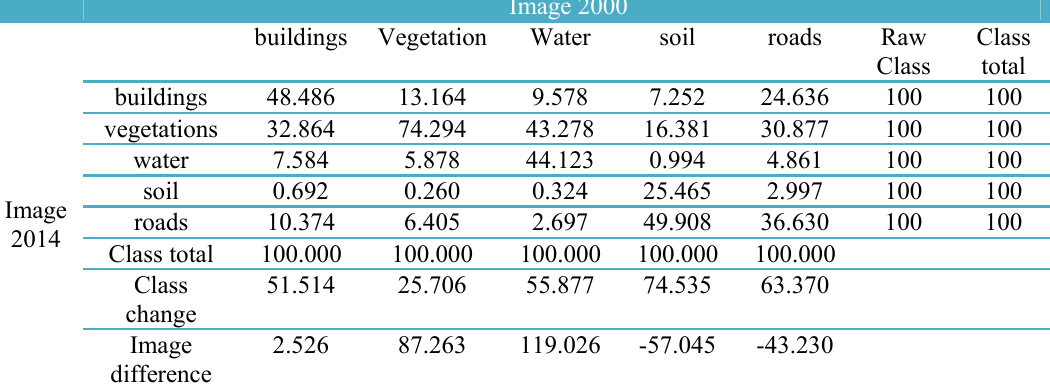
Table 5: The statistic properties of the initial and final classes using percent form.